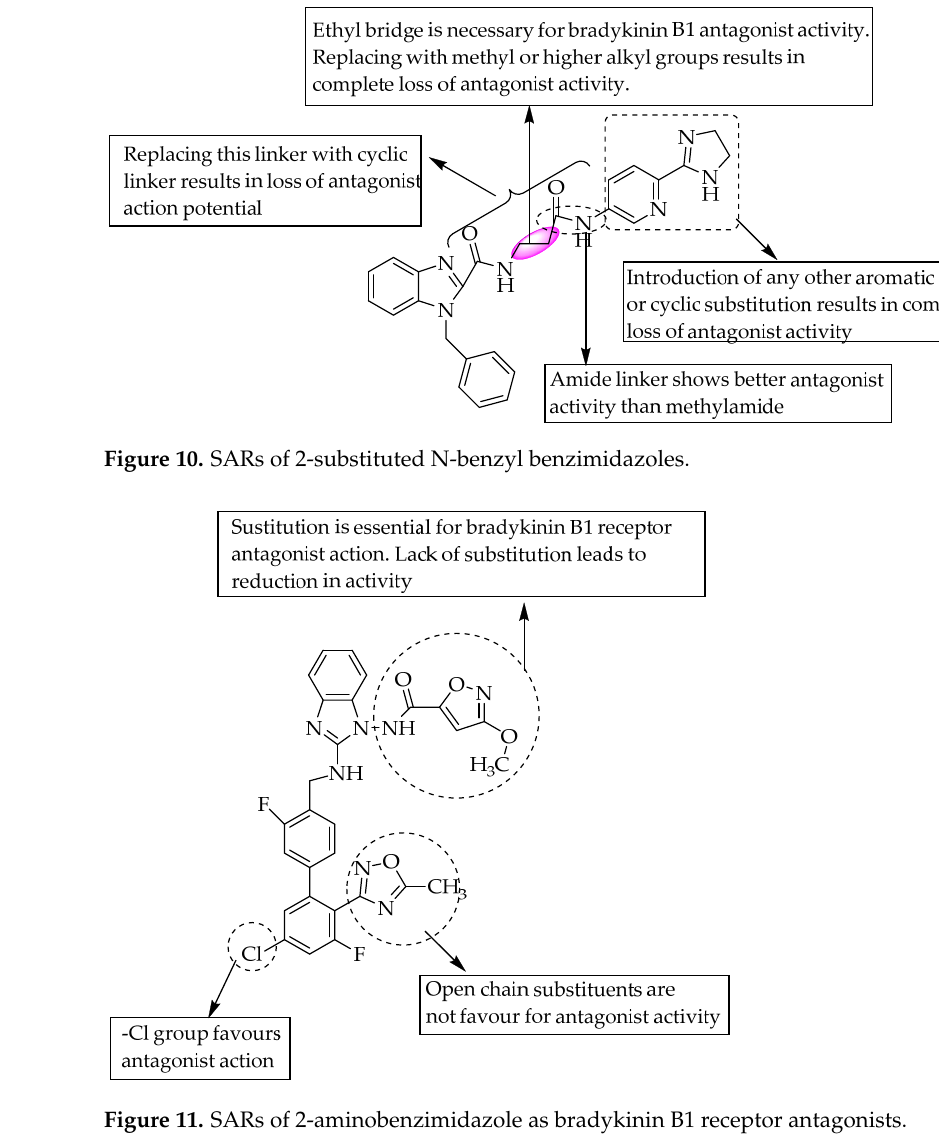
Figure 11. SARs of 2-aminobenzimidazole as bradykinin B1 receptor antagonists.